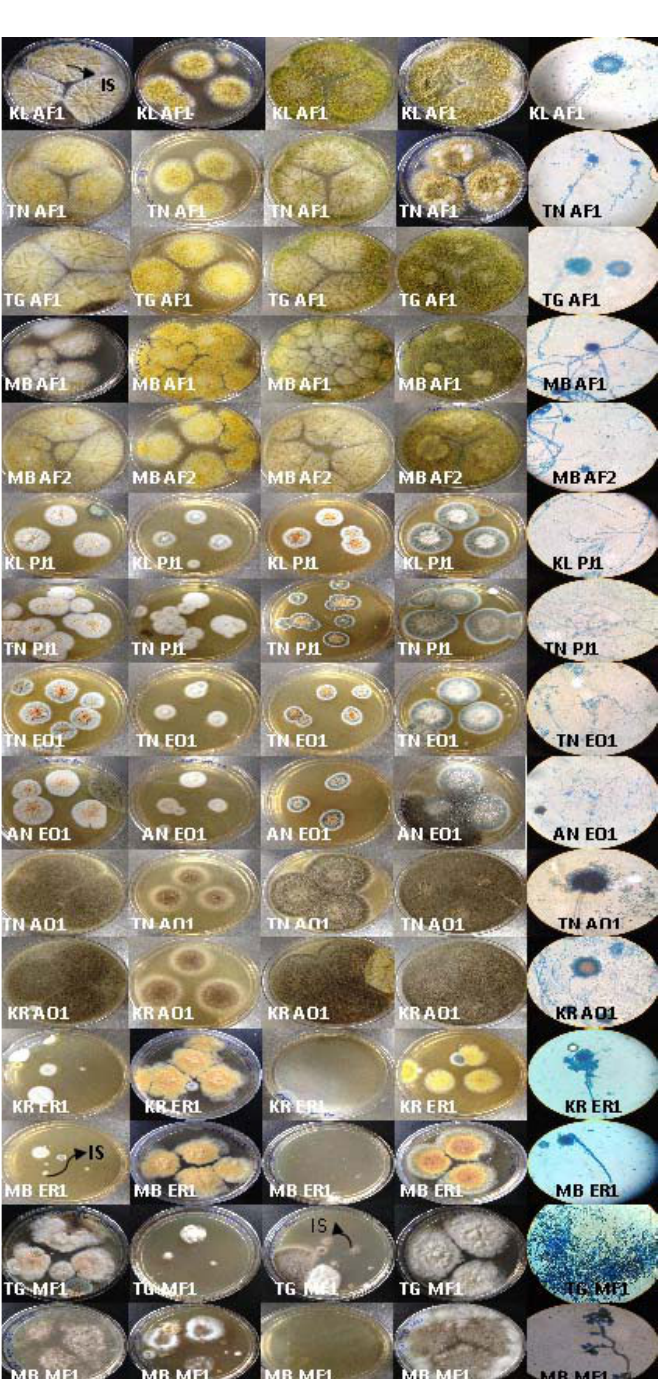
Fig. 4. Isolates of Aspergillus flavus , Penicillium janthinellum , Eupenicillium ochrosalmoneum , Aspergillus oryzae , Eurotium repens and Miscellaneous fungi grown on CYA 25°C, G25N 25°C, CYA 37°C, CY20S 25°C and microscopic